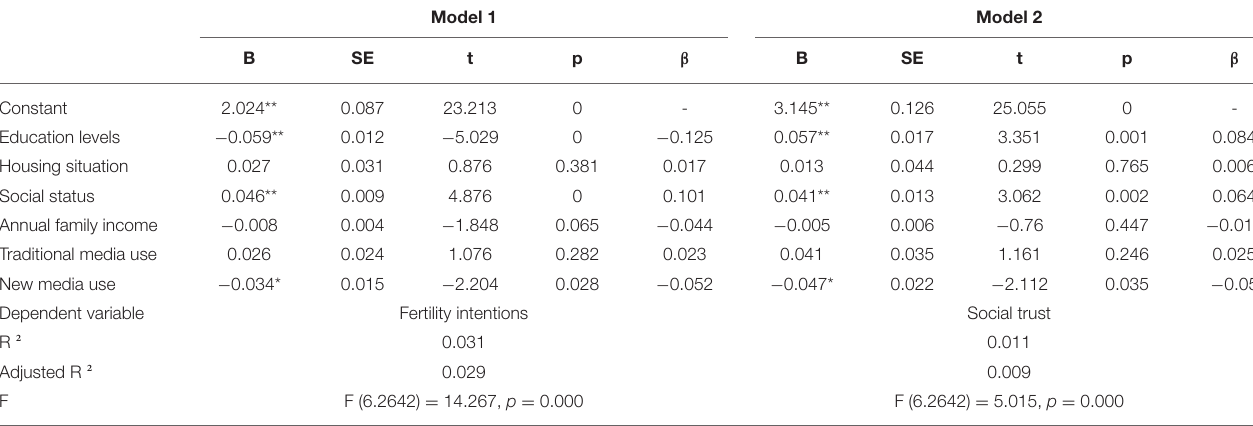
TABLE 6 | Results of mediating effect analysis ( n =